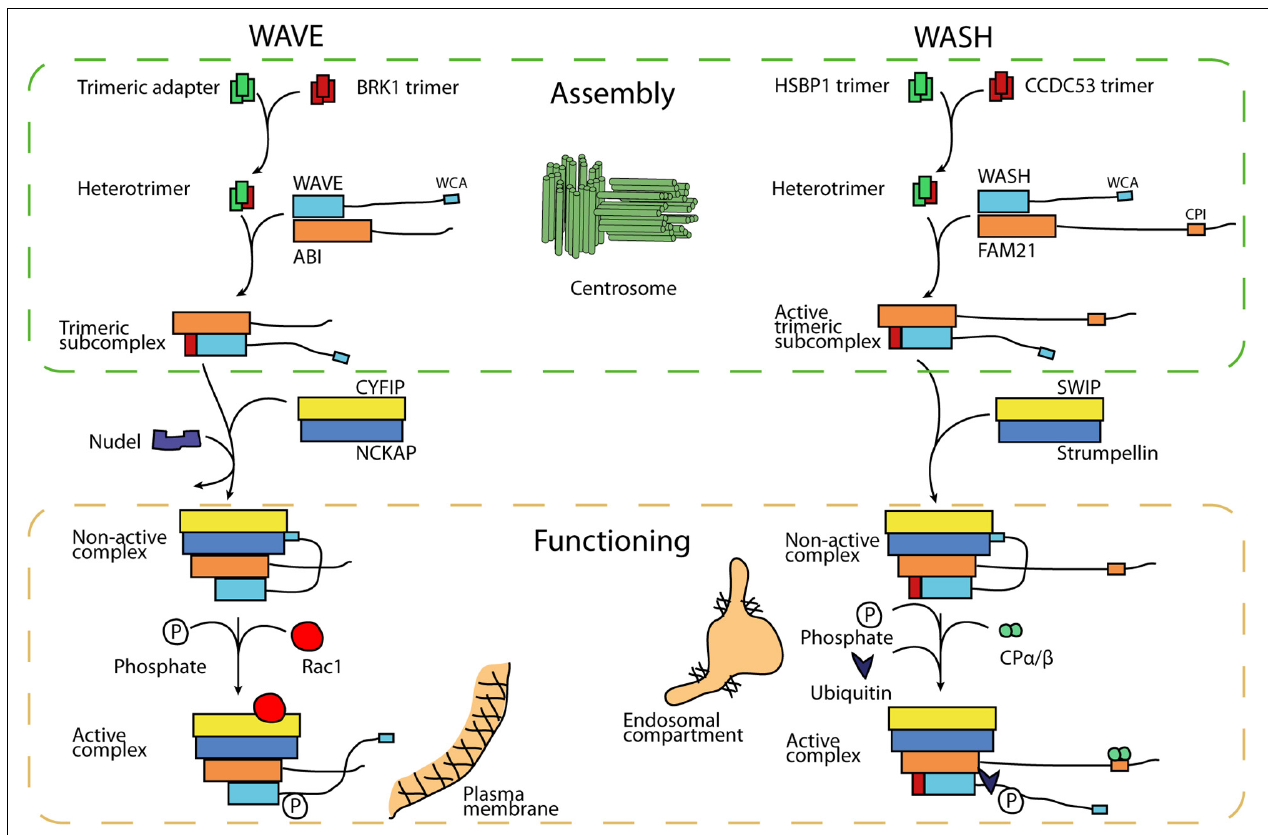
FIGURE 1 | Model of assembly and activation of WAVE and WASH complexes. Smallest subunits, BRK1 and CCDC53 respectively, also exist as free trimers, which are precursors of the complexes. In order to assemble a first trimeric subcomplex, these trimers have to be dissociated in order to contribute a single subunit to complex assembly. HSBP1, a centrosomal protein, promotes this step in the case of the WASH complex. Nudel promotes the assembly of the pentameric WAVE complex. The WAVE complex is inactive and must be activated by the small GTPase Rac1 and through phosphorylation of the WAVE protein within the complex. The WASH complex, in contrast, is active already in its intermediate trimeric state. Activation of the fully assembled WASH complex requires phosphorylation and K63-linked ubiquitination of WASH.